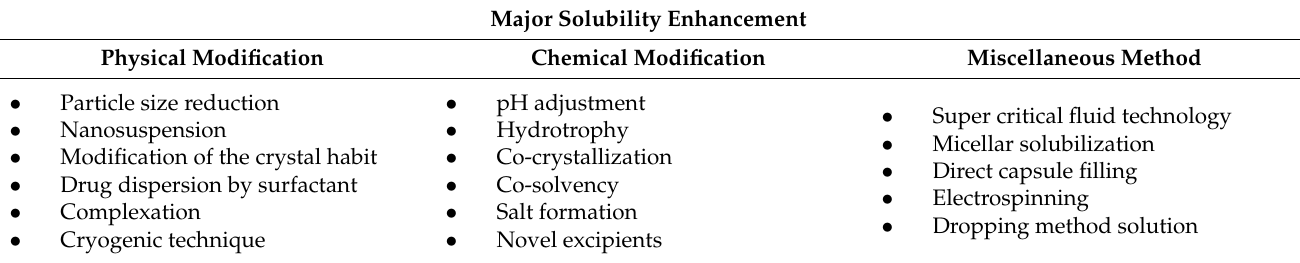
Table 3. Major techniques for solubility